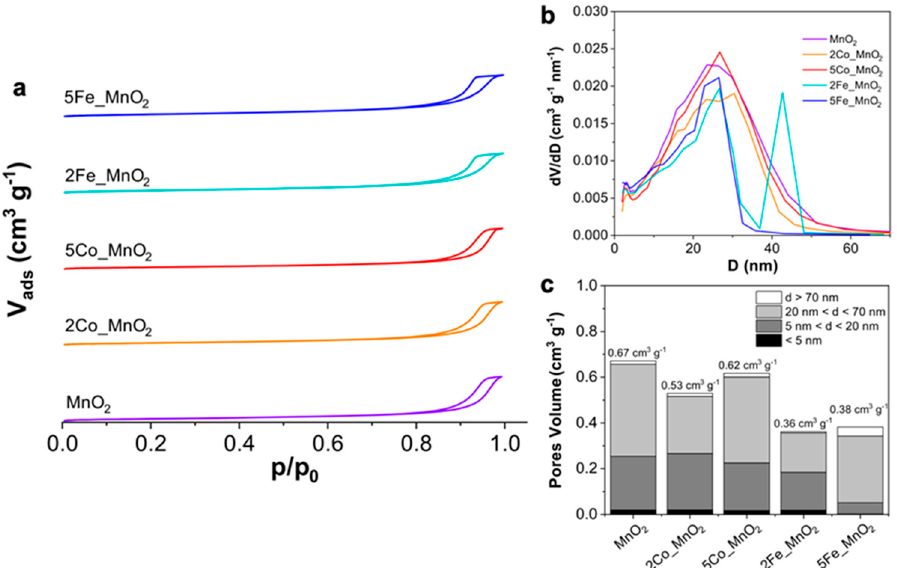
Figure 5. Comparison of ( a ) Brunauer-Emmett-Teller (BET) isotherms and ( b ) Barrett-Joyner-Halenda (BJH) pore-size distribution of all the as-synthesized nanoelectrocatalysts; ( c ) histogram showing the pores volume distribution together with the total pore